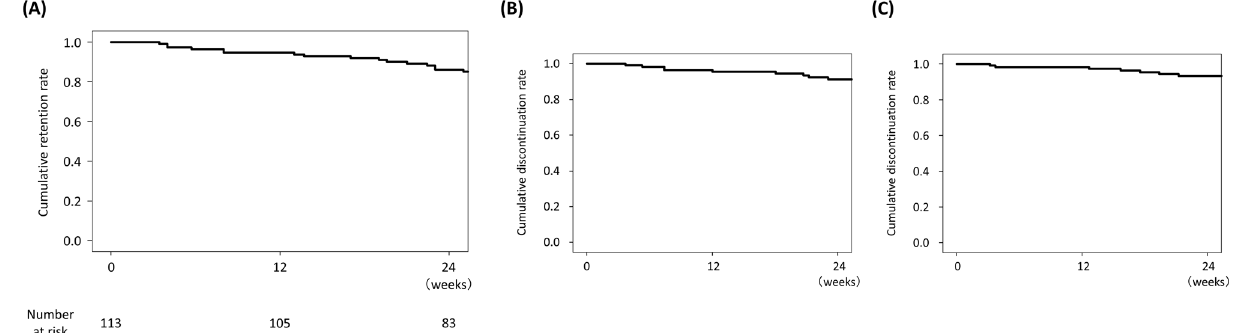
Figure 2. Kaplan–Meier curves for time to discontinuation of baricitinib. ( A ) Overall drug retention rate. ( B ) Drug retention rate with discontinuation due to inadequate response as the endpoint. ( C ) Drug retention rate with discontinuation due to adverse events as the endpoint.